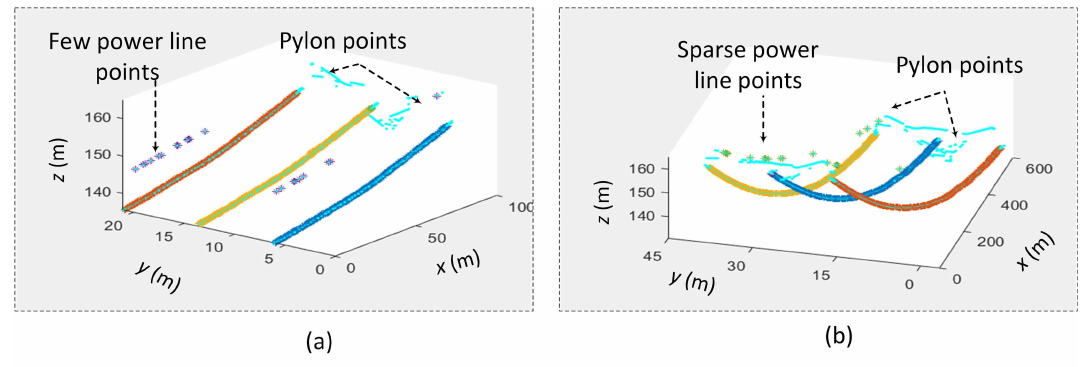
Figure 14. Robustness to density. In panel ( a ) the origin (0, 0) represents (4.086 × 10 5 , 5.90368 × 10 6 ) and in panel ( b ) the origin (0, 0) represents (5.136 × 10 5 , 6.92272 × 10 6 ).